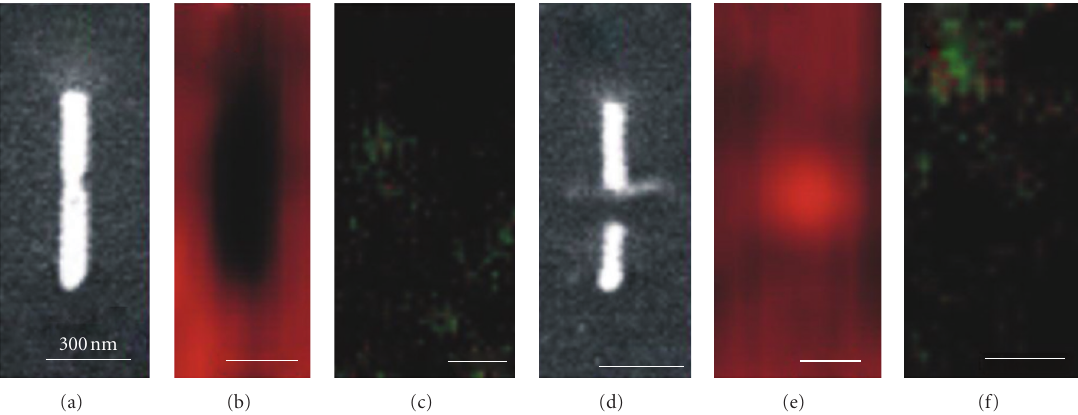
Figure 13: (a–c) Gold nanoantenna not exposed to FIB milling after surface functionalization: (a) SEM image, (b) optical transmission microscopy image, and (c) fluorescence microscopy image. (d–f) Same respective images for a gold nanoantenna where the gap size had been increased by FIB milling but without exposing the lower ITO